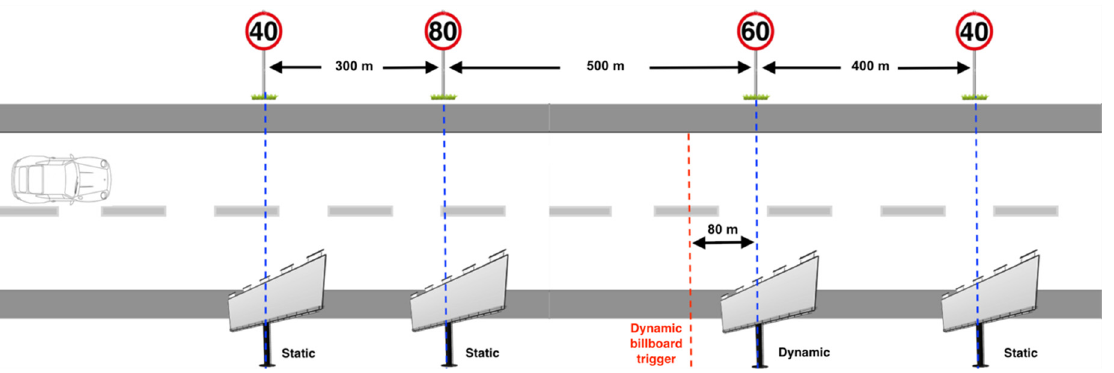
Figure 3. An illustration of the experiment design. Figure 2. A screenshot showing the first-person perspective driving in the driving simulator. The right bottom corner 3D axis legend is added separately. Table 1. Unity driving simulator parameters quantifying speed signs and digital billboards.